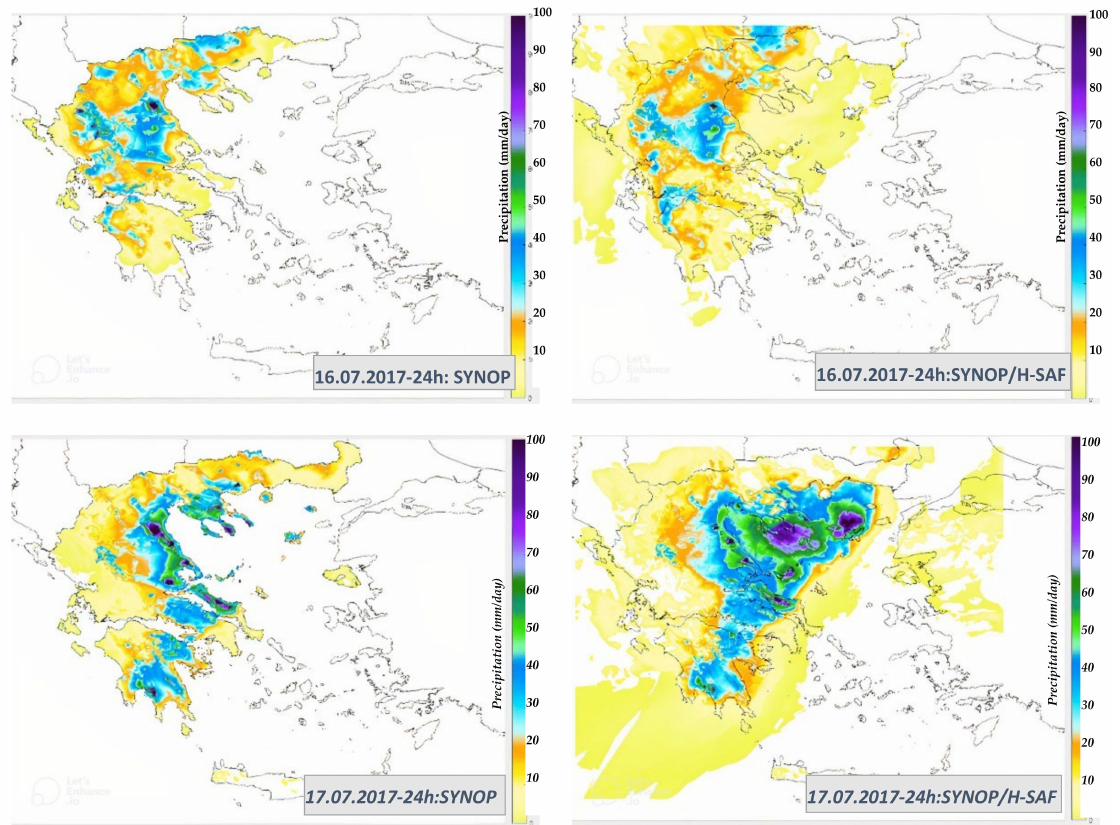
Figure 5. Gridded 24 h interpolated obs derived from MISH using only SYNOP obs ( left ) and SYNOP obs together with background H-SAF data ( right ). Precipitation color range: <10 mm/day-light yellow to 100 mm/day-dark